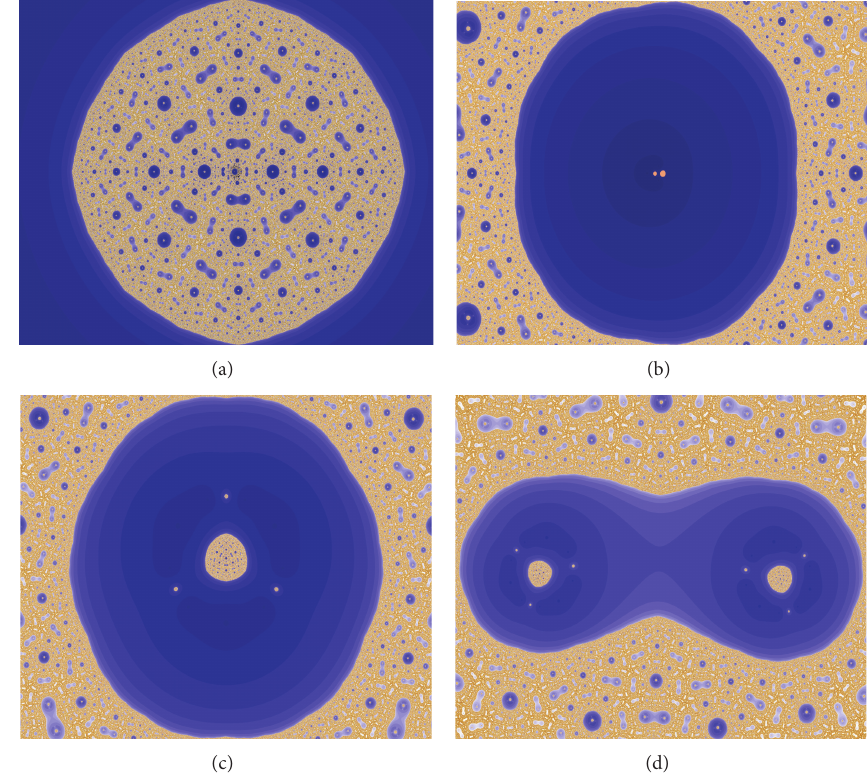
𝐽(̃𝑅(𝑧,1/20)) Figure 1: The Julia set and three Fatou components of